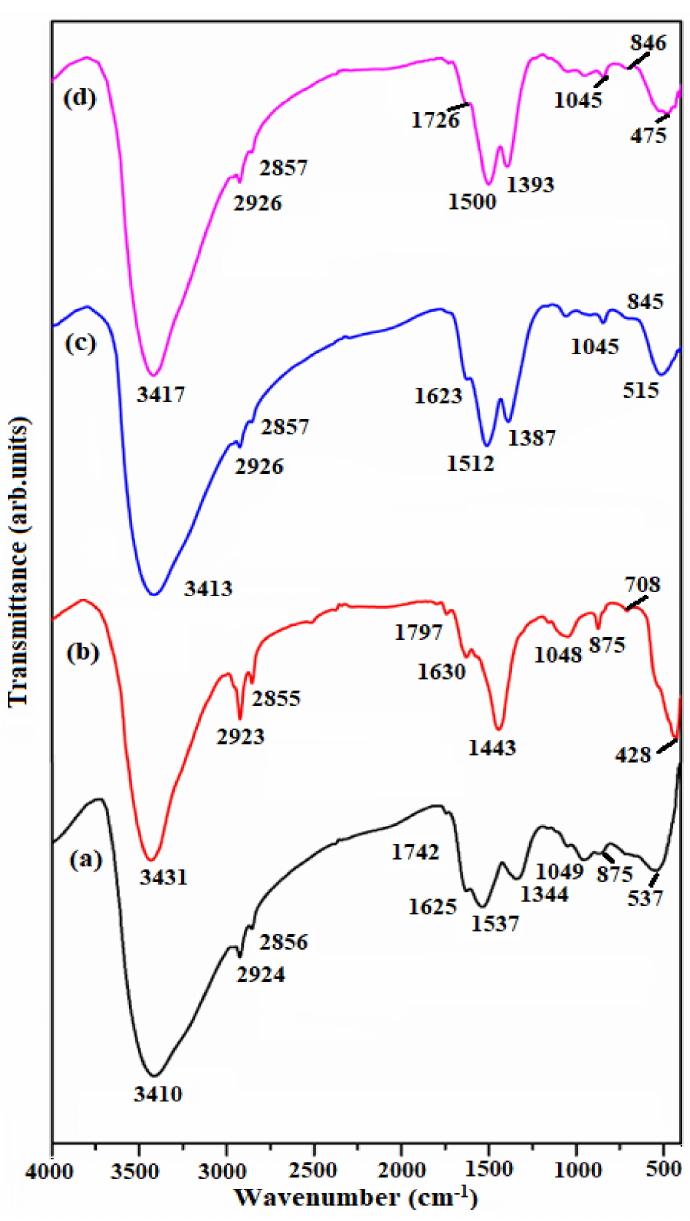
Figure 2. FT-IR analysis of ( a ) CeO 2 , ( b ) GO-ZnO, ( c ) ZnO@CeO 2 and ( d ) GO-ZnO@CeO 2 . The structural information of CeO 2 , GO-ZnO, ZnO@CeO 2 and GO-ZnO@CeO 2 nanohybrids were investigated by X-ray diffraction analysis and their results are revealed in Figure 3. X-ray diffraction patterns of cubic structure CeO 2 (JCPDS cars no. 34-0394) exhibit diffraction peak 2 θ values at 28.6 ◦ , 33.5 ◦ , 46.7 ◦ , 56.8 ◦ and 68.7 ◦ , which is well indexed to the lattice planes corresponding to (111), (200), (220), (311) and (222), respectively [27]. The powder XRD pattern of GO-ZnO nanohybrids was obtained in the diffraction peaks at 2 θ = 31.3 ◦ , 34.1 ◦ , 36.3 ◦ , 47.8 ◦ , 56.7 ◦ , 62.8 ◦ and 69.4 ◦ corresponding to the (100), (002), (101), (102), (110), (103) and (112) characteristic crystal diffraction planes of ZnO (hexagonal structure) as (JCPDS-36-1451) confirmed [28,29]. In addition, a low intensity